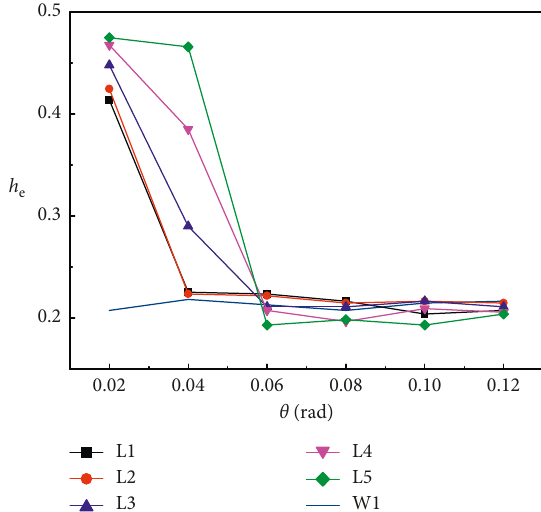
Figure 16: Equivalent viscous damping coefficient of frames with pulling damaged joints.